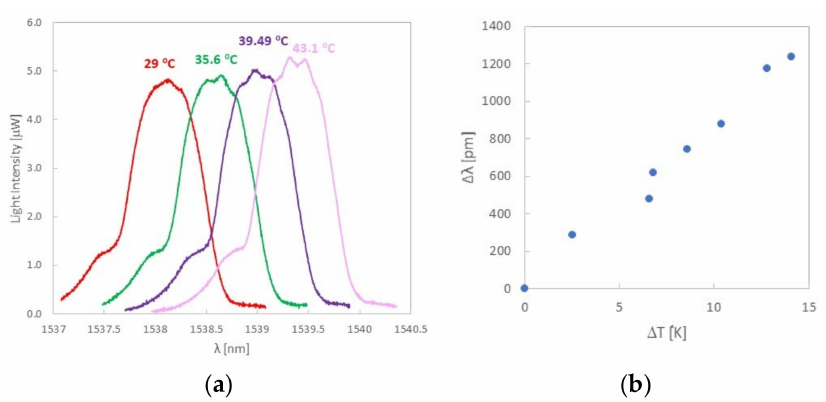
Figure 9. Change of the Bragg wavelength as a function of temperature ( a ) and determination of temperature sensitivity ( b ) for a rectangular bar with a thickness of 6